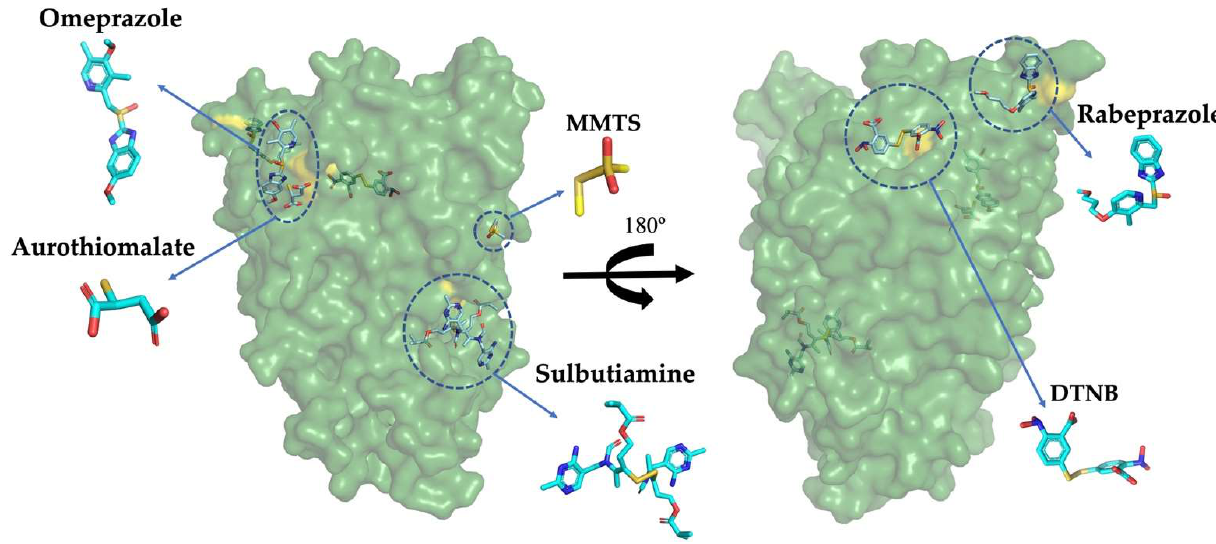
Figure 3. Two views of the GlADI monomer A rotated 180°, showing the global distribution of all the studied molecules in their putatively best ranked binding sites. To make the visualization easier, the structure is displayed with 50% trans- parency.